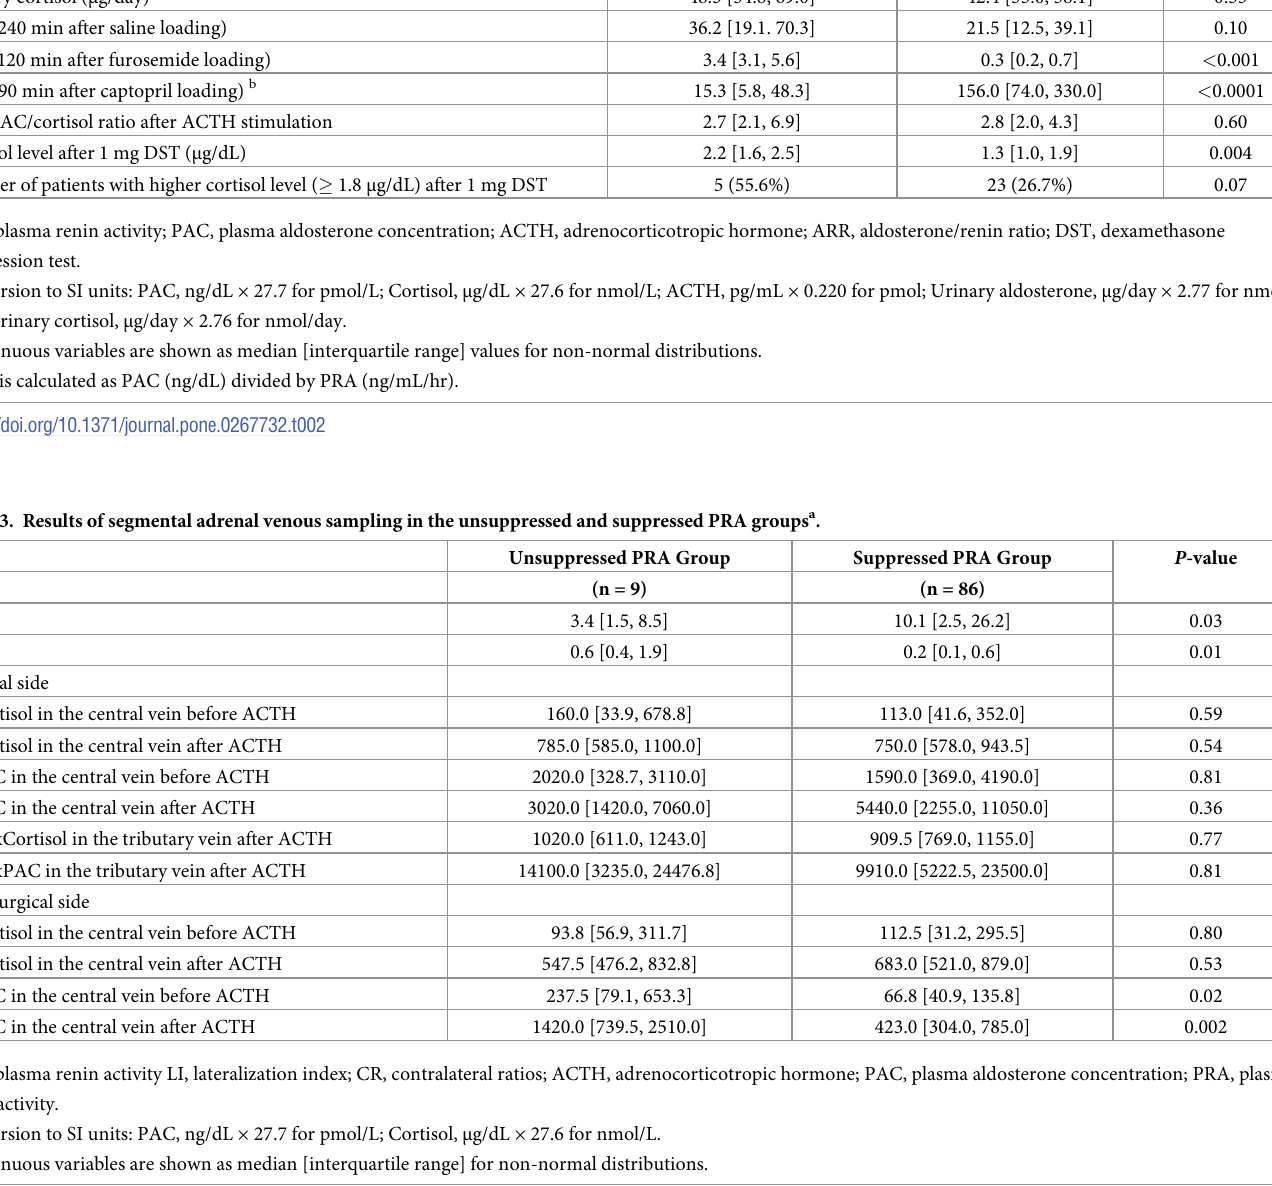
Table 3. Results of segmental adrenal venous sampling in the unsuppressed and suppressed PRA groups a .